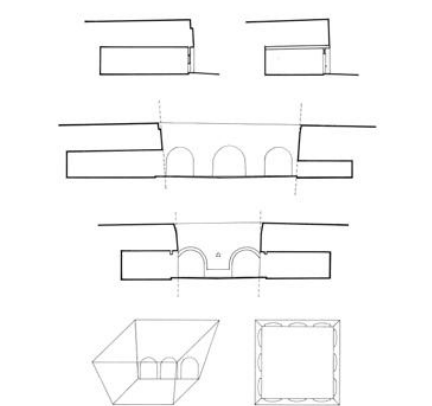
Figure 4. 4 pieces of vertical walls are not absolutely 90 ° vertical to the ground